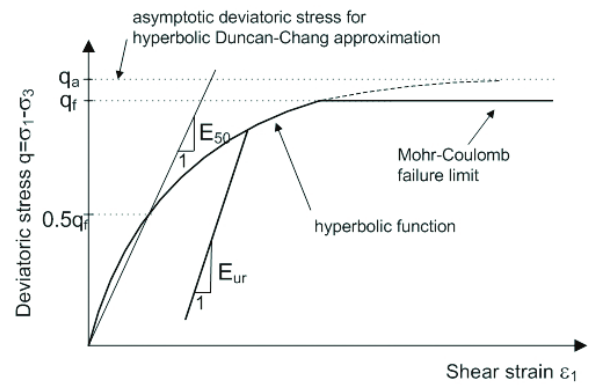
Fig. 5. Hyperbolic stress-strain relationship and the definition of different moduli in the triaxial drained test condition